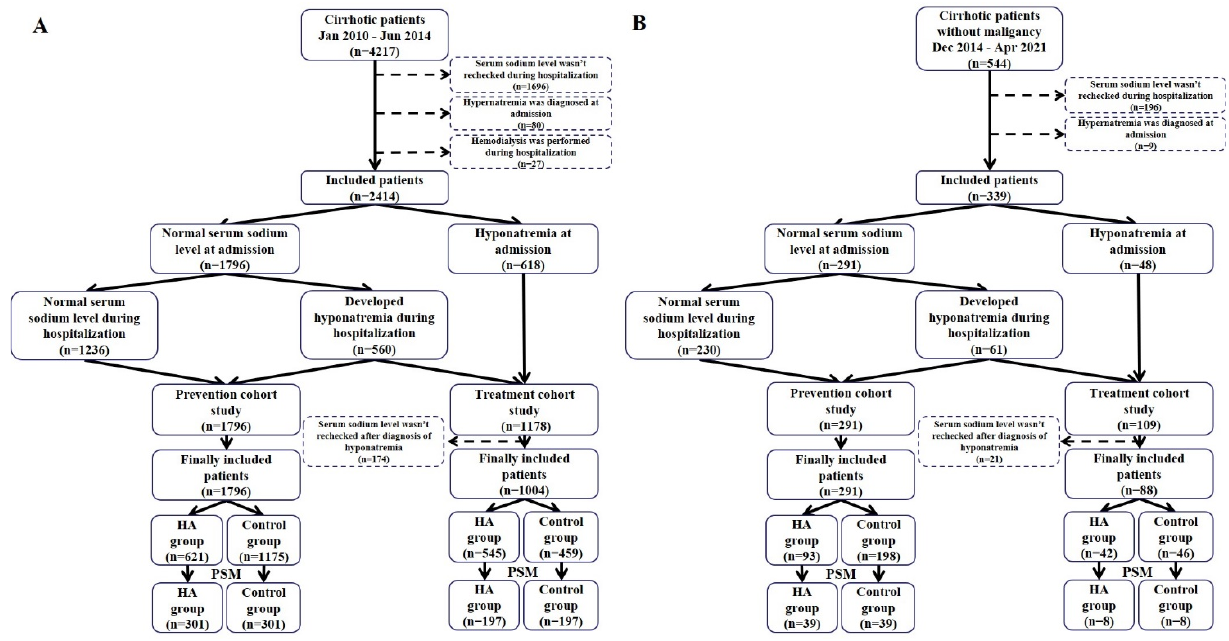
Figure 1. Flow charts of patient selection in the Hospitalization outcome ( panel A ) and Long-term outcome ( panel B ) cohorts . Abbreviations: PSM: propensity score matching; HA: human albumin.